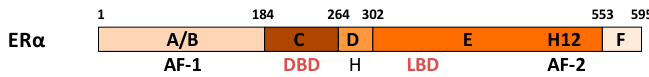
Figure 1. Schematic representation of human estrogen receptors (ER α ) protein. ER α protein exhibits six domains, A to F, oriented from the amino (N) to carboxyl (C) terminus. The domains which locate key functions are indicated: activation function (AF)-1 and AF-2 mediate transcriptional activity. The DNA binding domain (DBD) interacts with estrogen responsive element (ERE) DNA motifs, and the ligand binding domain (LBD) binds E2. H is the hinge domain. Helix 12 (H12) interacts with transcriptional activators and repressors following ligand binding.